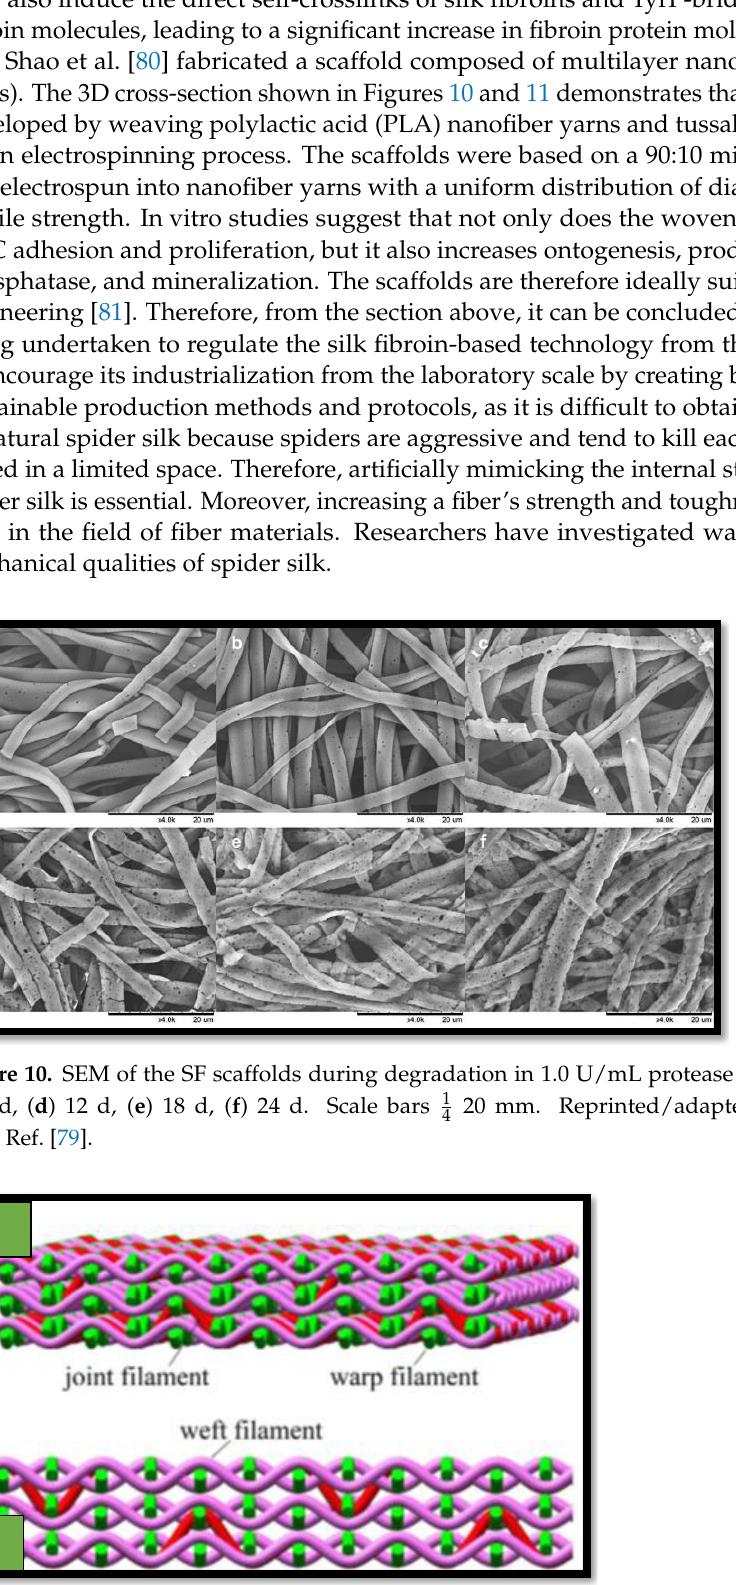
Figure 11. ( A ) 3D and ( B ) cross-section schematics of MLNFF scaffolds. Reprinted/adapted with permission from Ref. [80].